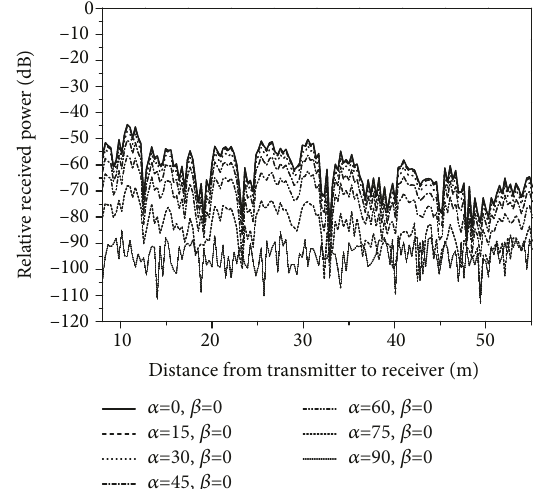
Figure 7: The relative received power for di ff erent inclination angles for the LOS corridor ( β = 0 ∘ , N = 10 , M = 8 , G T = 1 dBi, and G R = 1 dBi).